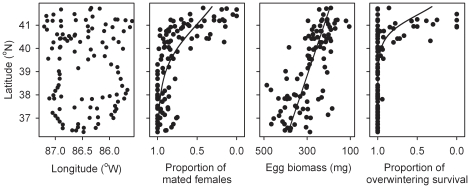
Female fitness in 2008.Spatial distribution of host plants of bagworms, Thyridopteryx ephemeraeformis, sampled in Indiana, Kentucky, and Tennessee to determine multiple components of female fitness during the 2008 bagworm generation (Table 1). Latitude (x) significantly affected the proportion of mated females [logistic model with 110 sites, y = e (43.3−1.05 x)/(1+e (43.3–1.05 x)), χ = 393.46, P<0.0001], fecundity [linear model with 100 sites (excluding sites with none or <3 overwintered egg masses), y = 1698−36.0 x, r2 = 0.496, P<0.0001] and the proportion of overwintering survival [logistic model with 104 sites (excluding sites with <3 egg masses sampled), y = e (89.3−2.16 x)/(1+e (89.3−2.16 x)), χ = 104.41, P<0.0001).